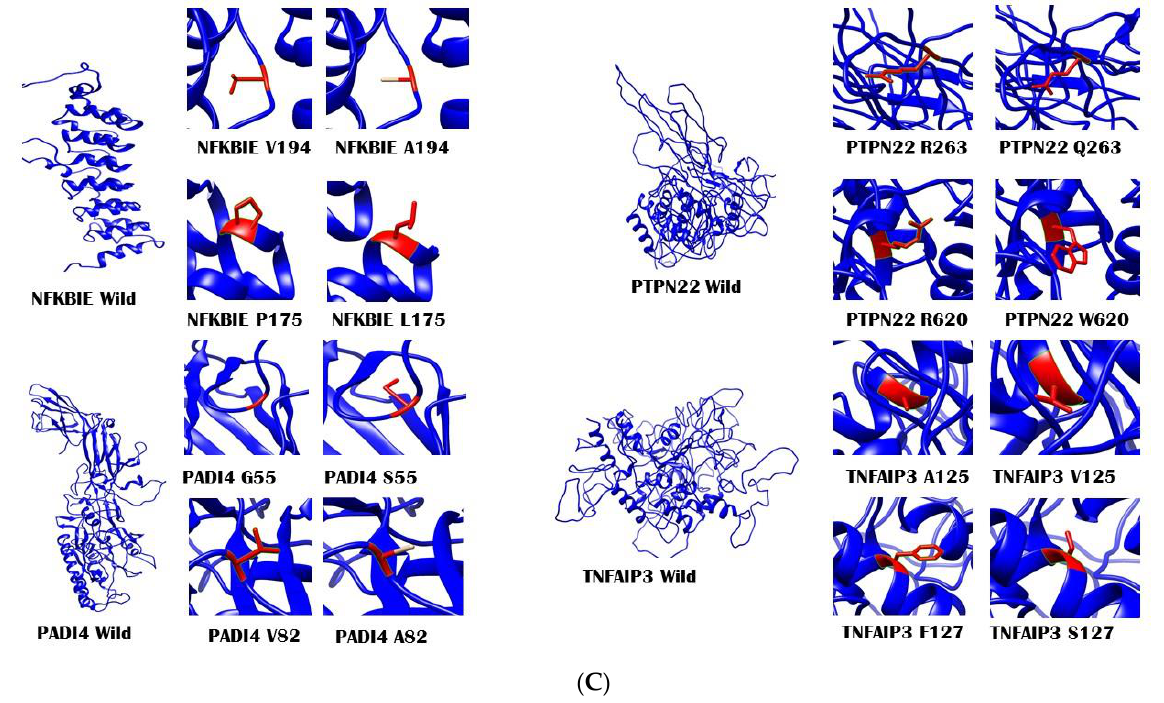
( C ) Figure 3. Modeled structures using MODELER v9.22 for wild-type proteins along with a close-up of wild and mutated amino acid residues. ( A ) Modeled structures for CTLA4, FCGR2A, CD226, AIRE, FCGR2B, IL6R, PLD4, and PRKCH. ( B ) Modeled structures for RTKN2, YDJC, SH2B3, TYK2, WDFY4, and IRAK1. ( C ) Modeled structures for NFKBIE, PADI4, PTPN22, and TNFAIP3. All the protein structures were visualized, and figures were generated using Chimera v1.11 software (https://www.cgl.ucsf.edu/chimera/, accessed on 3 February 2021). The structures were then assembled and combined using Microsoft PowerPoint 2016. Table 6. Percentage identity and coverage of the best-matching templates for query proteins. Table 7. Ramachandran plot analysis percentages of favored, allowed, and outlier residues for the Identity Coverage Identity Coverage modeled Query Protein Templates Query Protein Templates (%) (%) (%) (%)